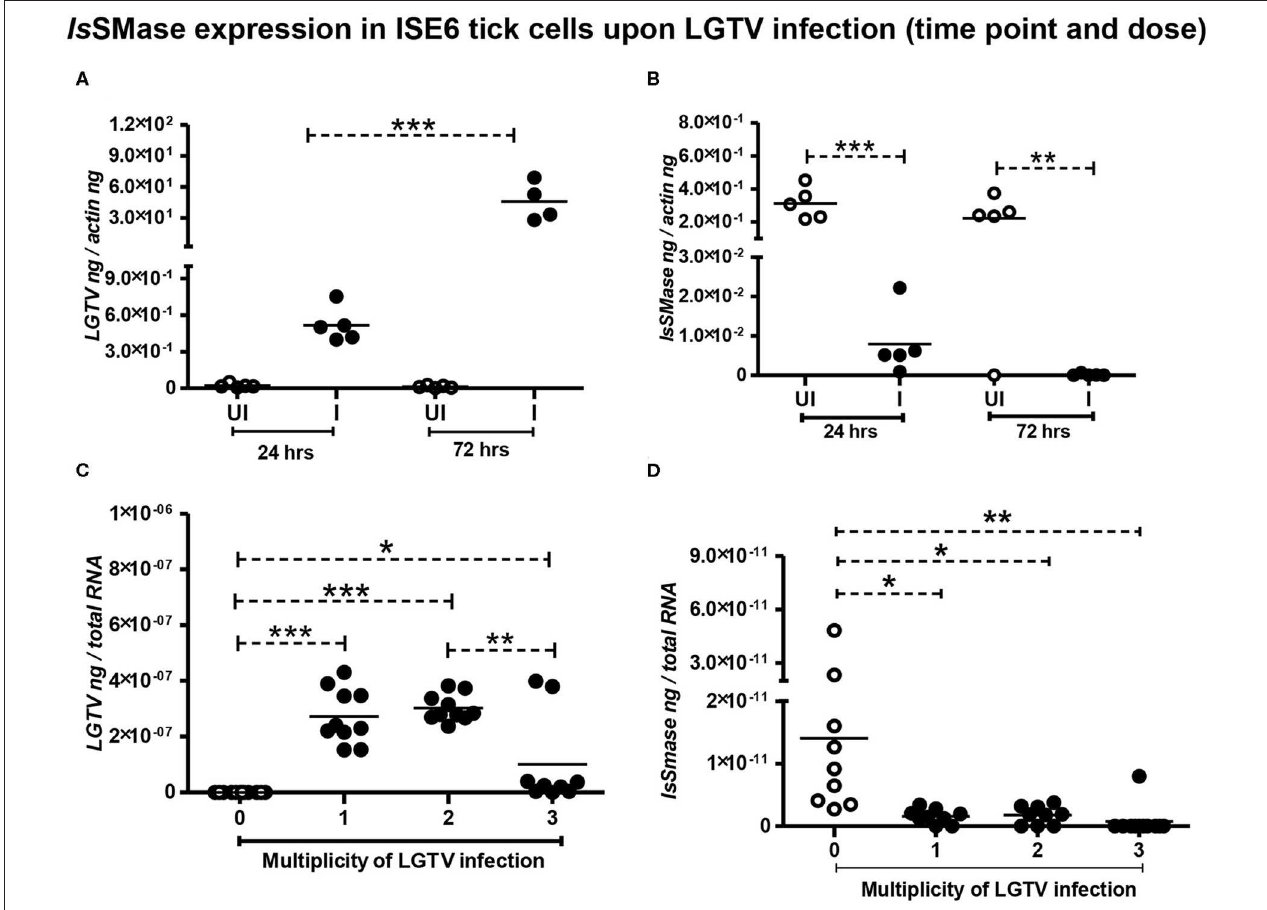
FIGURE 4 | Reduced Is SMase expression upon LGTV infection is time and dose dependent. QRT-PCR analysis showing LGTV viral loads (A,C) or Is SMase gene expression levels (B,D) at different time points (A,B) , or doses (C,D) in tick cells. LGTV loads (A) and Is SMase transcript levels (B) were determined at two different time points of 24 and 72h p.i. (C,D) , numbers (1, 2, 3) indicate multiplication of infection (MOI) corresponding to LGTV loads (C) or levels of Is SMase transcripts (D) in uninfected (0) or LGTV-infected (1, 2, 3 MOI) tick cells. Each circle indicates sample generated from one culture well analyzed as 5–10 replicates. Open circles represent the uninfected (UI or 0) group, whereas closed circles denote the LGTV-infected (1, 2, and 3 in dose or I in time points) group. LGTV loads or Is SMase mRNA levels were normalized to tick beta-actin levels. P -value determined by Student’s two-tailed t -test is shown. The asterisk indicates significance, and *, **, or *** denotes a P -value of less than 0.05, 0.01, and 0.001,